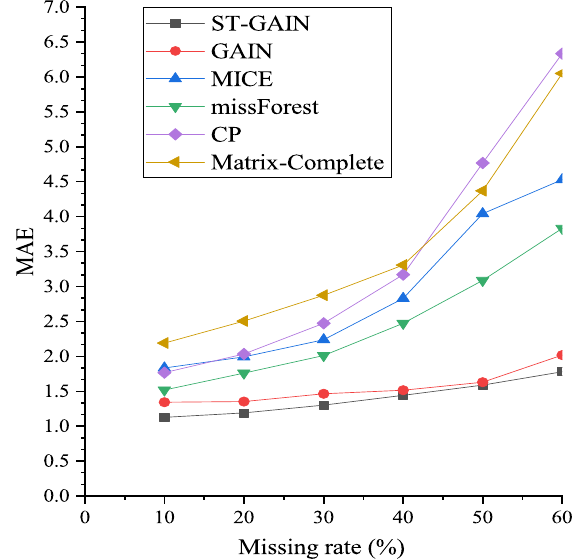
Figure 9. MAE for different miss